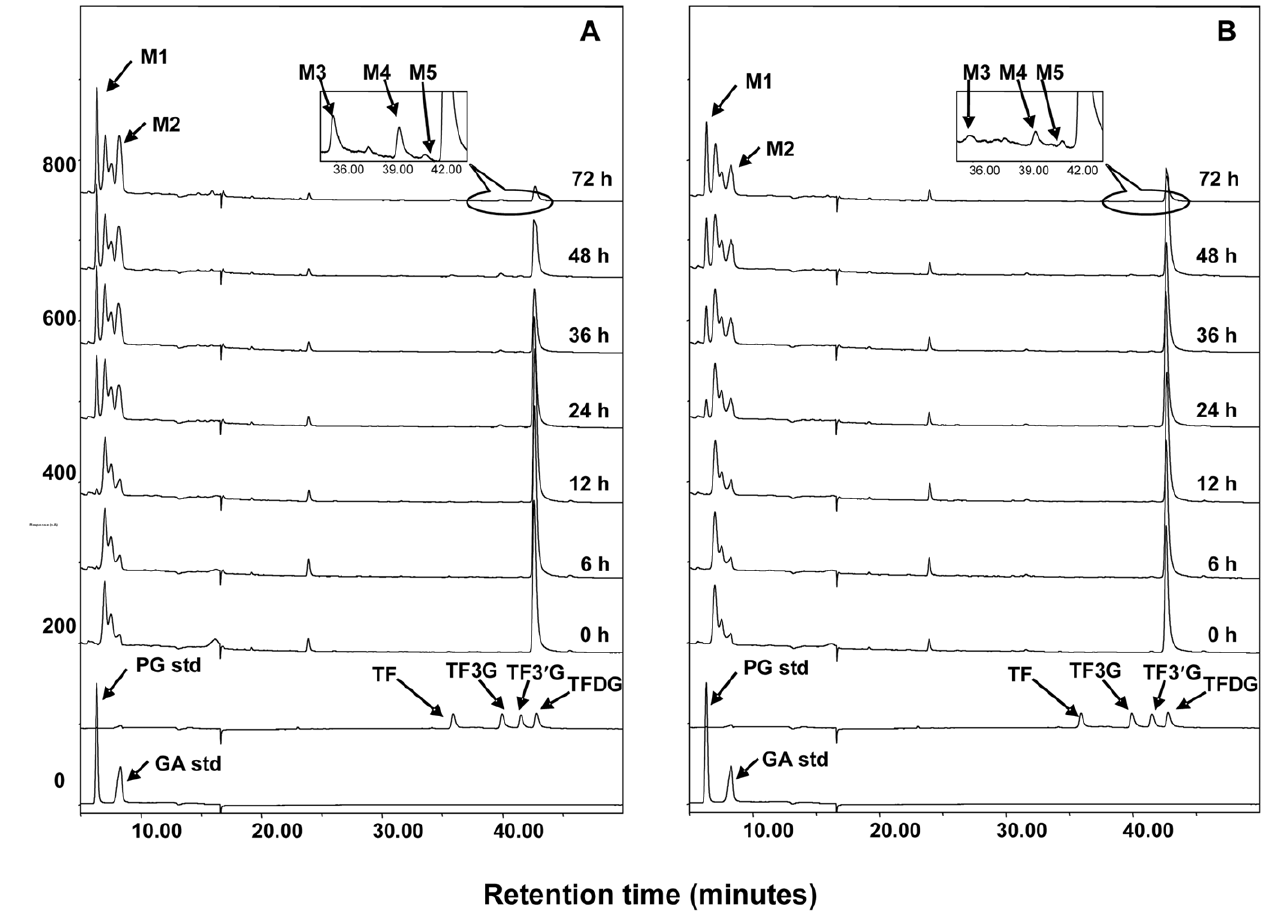
Figure 7. HPLC-ECD chromatograms of microbial metabolites of TFDG after incubation with Lactobacillusplantarum 299v (A) and Bacillussubtilis (B). TFDG: theaflavin 3,3 9 -digallate.